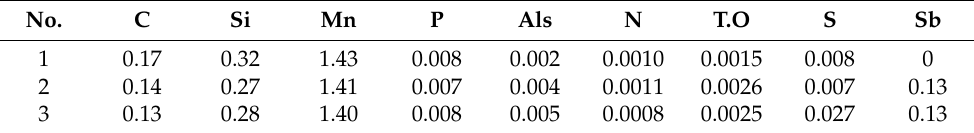
Table 1. Chemical composition of experimental steels (wt.%).